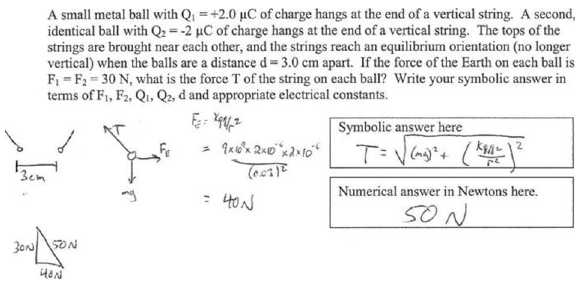
FIG. 3. Electrostatics challenge problem and example